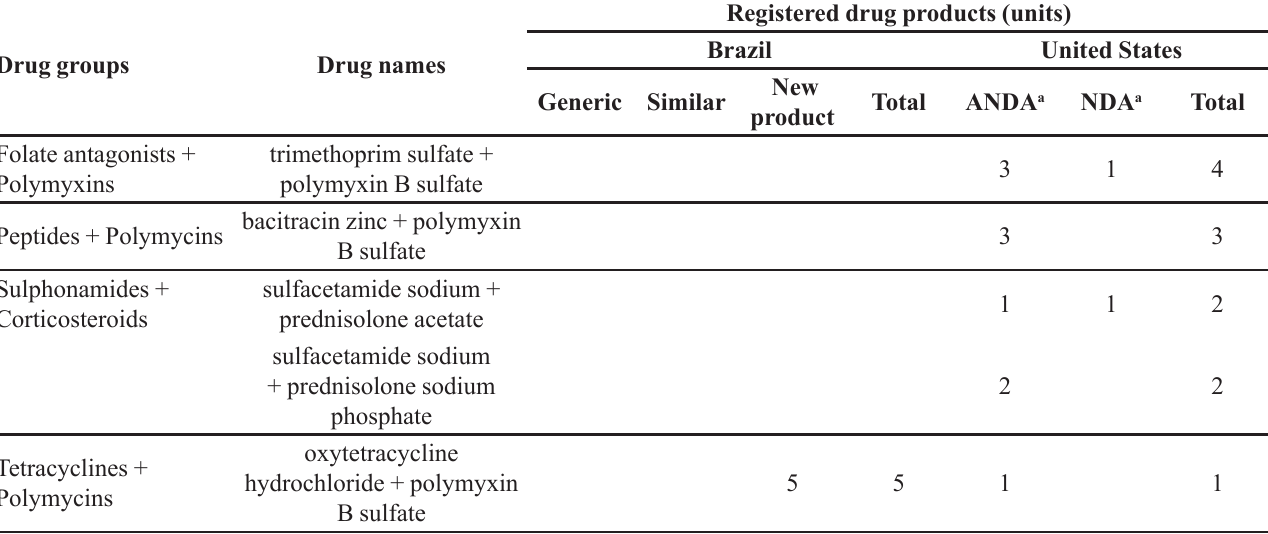
TABLE II - Comparison of drug substances groups registered as combined ophthalmic products in Brazil and in the United States